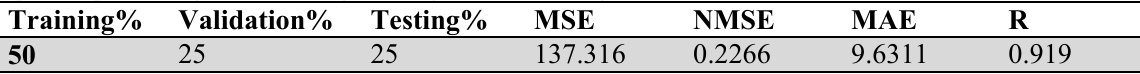
Optimal percentage for training, testing and validating for data used in neural networks